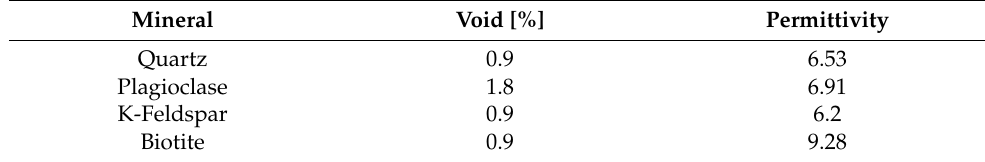
Table 3. Values of void volume * and permittivity of minerals in granite [12,13]. Mineral